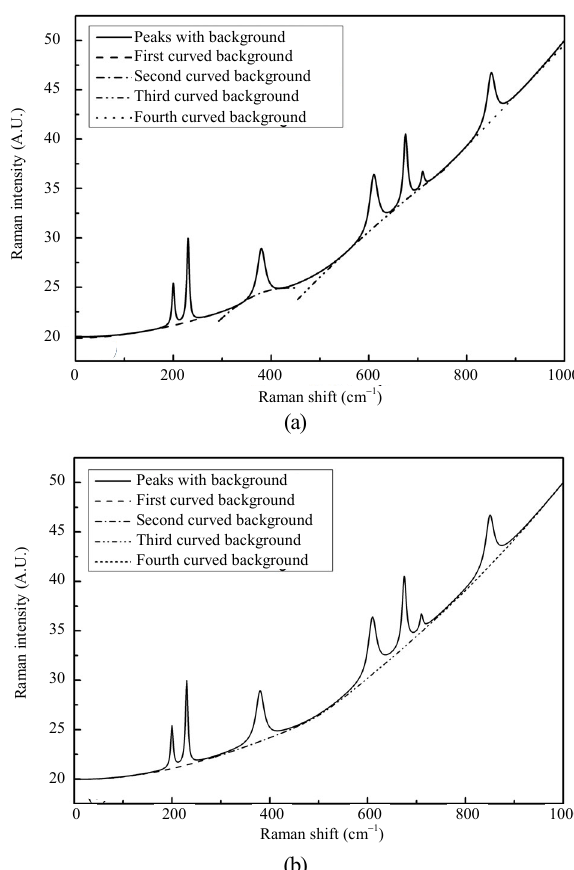
Fig. 6 Baseline correction for synthetic Raman spectrum : (a) final fitted background with discontinuity and (b) final fitted background without discontinuity.